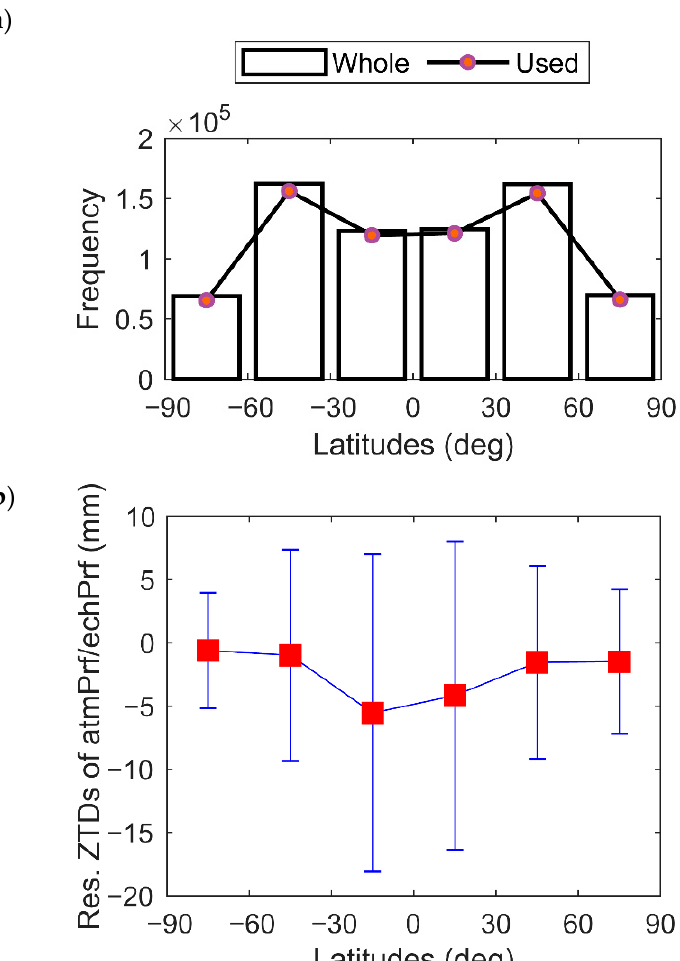
Figure 6. Latitudinal variations in 2008 of ( a ) the number of occultation events; and ( b ) residual ZTDs of matched atmPrf and echPrf.